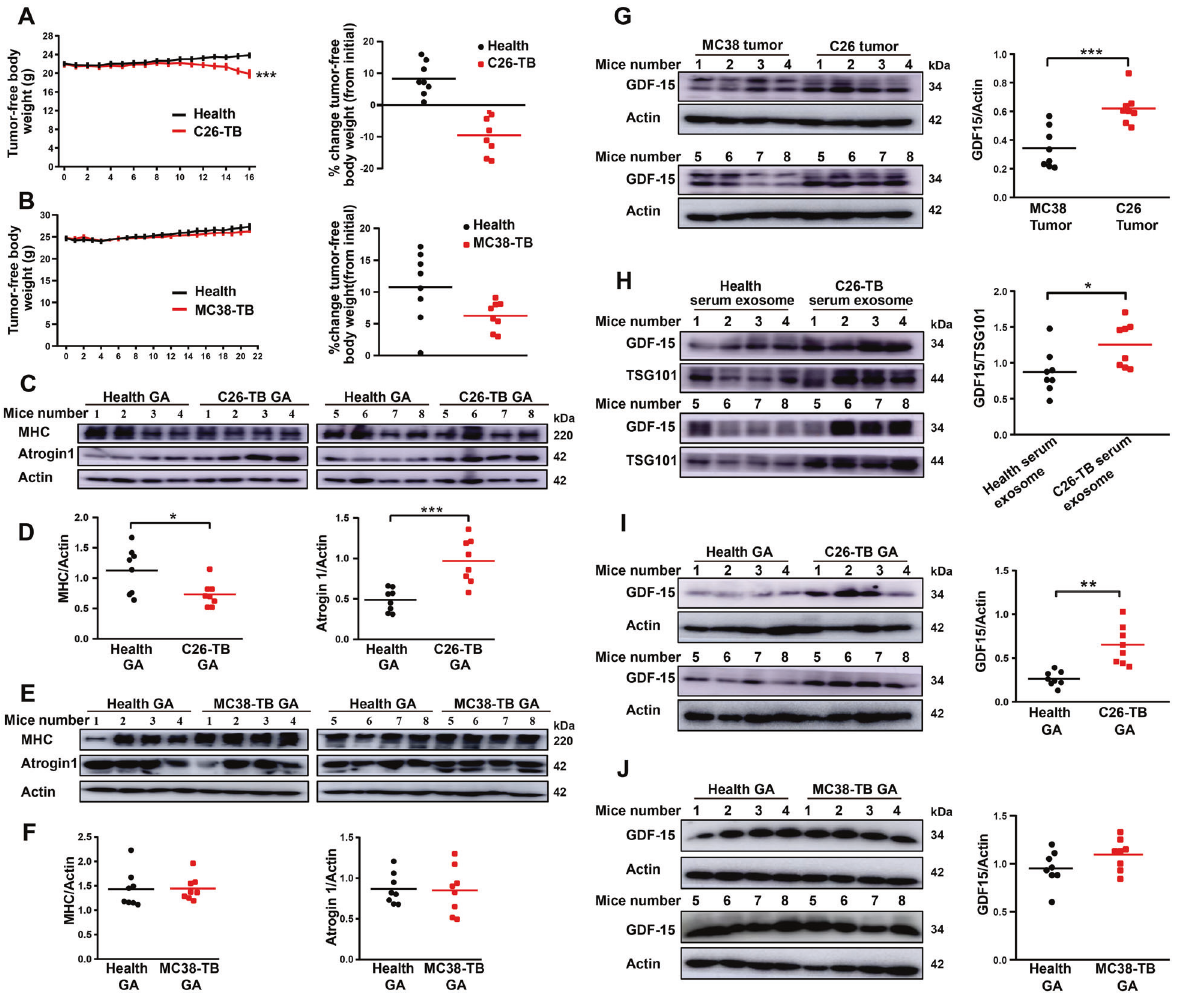
Fig. 3 High level of GDF15 in C26 tumor tissues, serum exosomes and GA muscle tissues of C26 tumor-bearing mice. C26 tumors cells (1 × 10 6 ) or MC38 tumor cells (1 × 10 6 ) were inoculated subcutaneously in the right fl ank of BALB/c or C57BL/6 J mice respectively with 100 μ L. Body weight and tumor volume were recorded every day until the end of experiment. A Time-related change in tumor-free body weight of the C26-bearing mice ( n = 8). B Time-related change in tumor-free body weight of the MC38-bearing mice ( n = 8). C , D Western blot analysis of MHC and Atrogin1 protein in GA tissues in C26-bearing mice compared to health group ( n = 8, * p < 0.05, *** p < 0.001; t test). E , F Western blot analysis of MHC and Atrogin1 protein of GA tissues in MC38-bearing mice versus health group ( n = 8). G Western blot analysis of GDF15 levels in MC38 tumor and C26 tumor tissues ( n = 8, *** p < 0.001; t test). H Western blot analysis of GDF15 content in serum exosome of C26- bearing mice versus health group ( n = 8, * p < 0.05; t test). I Western blot analysis of GDF15 protein levels in GA tissues of C26-bearing mice in comparison with health group ( n = 8, ** p < 0.01; t test). J Western blot analysis of GDF15 protein levels in GA tissues of MC38-bearing mice compared to health group ( n = 8). The data presented are the mean ±